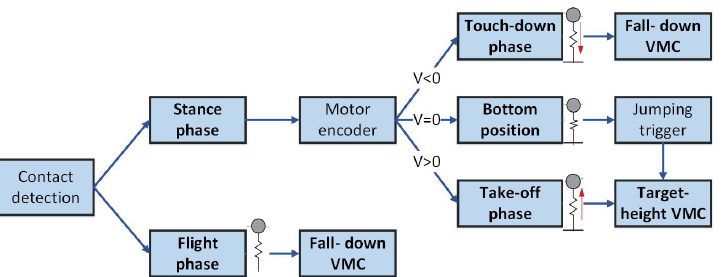
Figure 6. State estimation diagram in three different states in one hopping period. For height measurement in each jump, we used time difference in the flight phase to deduce the actually reached summit height. In the experiments, we measured ∆ T between adjacent takeoff and touchdown moments, and then used Equation (13), deduced from basic distance calculation formula, to compute the summit